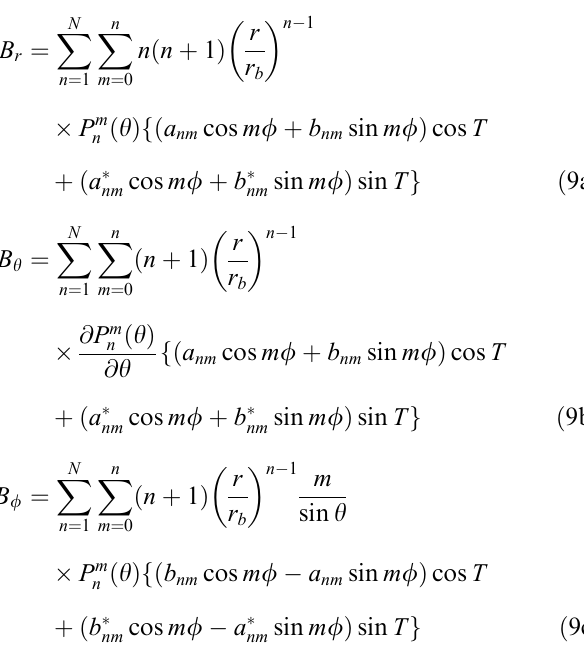
where h is the colatitude, / the longitude and r the radial distance. These equations are similar to the usual spherical harmonics expansions derived from a scalar potential. They di(cid:128)er only by the factors n (cid:135) 1, cos T and classical routines and sin T and powers of r r b developed for inner field calculations can be partially re-used. The three components take into account the amount of tilt and are multiplied by cos T and sin T . The best results were obtained retaining only terms in cos T .